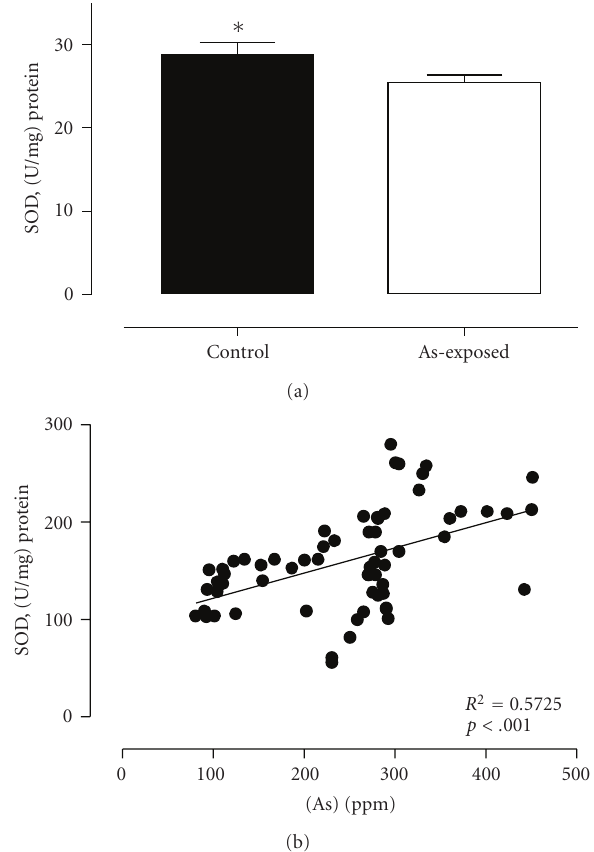
Figure 4: Comparative levels of SOD activity in plasma samples from low- and high-exposure human populations and correlation between SOD activity and urinary excretion of As from highly As- exposed population. (a) SOD activity in the plasma samples of the low-As-exposure group ( n = 31) and high-As-exposure group ( n = 50). Data are graphed as mean standard error ( P < . 0001). (b) Relationship between plasma SOD activity and As concentration in urine from highly exposed population ( P < . 0001). Statistical di ff erences of SOD activity between the groups were established according to U-Mann-Whitney